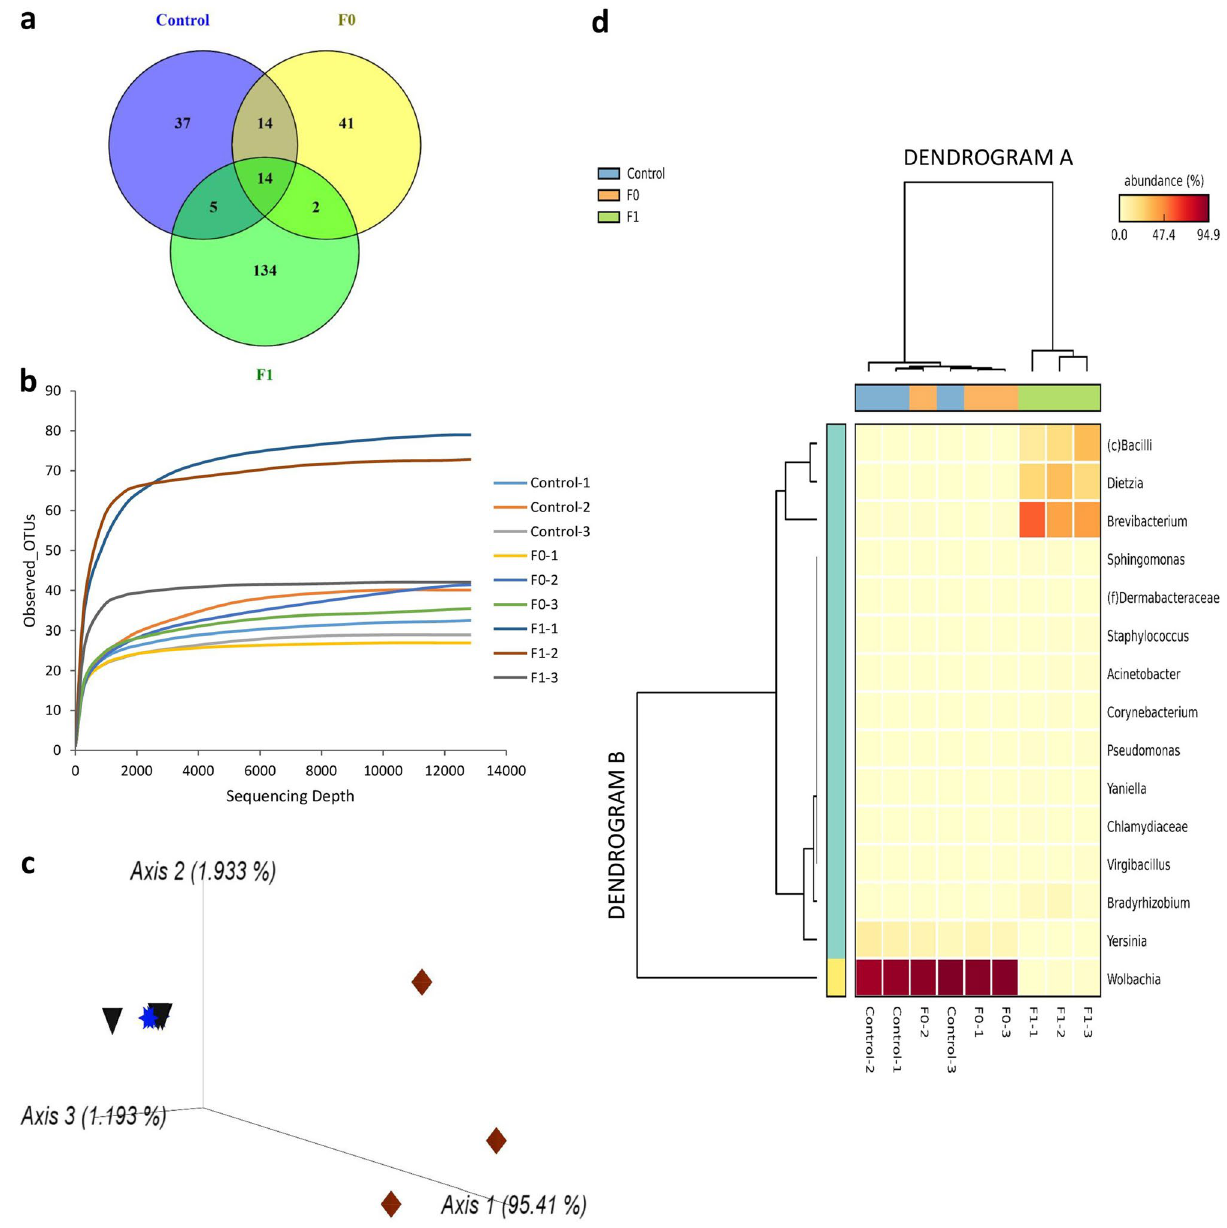
Figure 2. Effect of rifampicin treatment on microbial composition of C. hemipterus based on the 16S rRNA metagenomics analysis. ( a ) Venn diagram showing the number of shared and unique OTUs among the study groups; ( b ) Rarefaction curves of all samples from the study groups. Each line represents each replicate used in the respective study groups; ( c ) Principal coordinate analysis (PCoA) showing bacteria dissimilarity between the individuals from different experimental groups (rifampicin treated F0:blue star and F1: brown diamond ; control: black triangle) based on Bray–Curtis distance metric. Each symbol denotes individual replicate used in the respective study groups; ( d ) Heatmap dendrogram illustrating abundance (%) of top 15 genera in each sample from the three experimental groups (control, F0 and F1) and clustered by averaged neighbor UPGMA method at threshold of